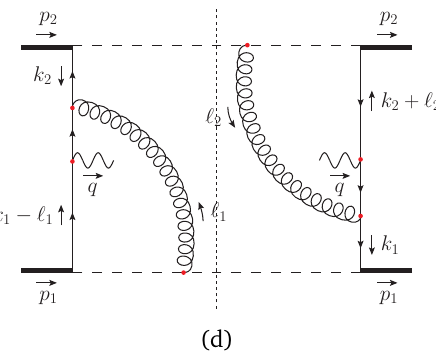
Figure 10: This diagram does not have an entangled colour structure, but is needed in the sum over diagrams to obtain the full